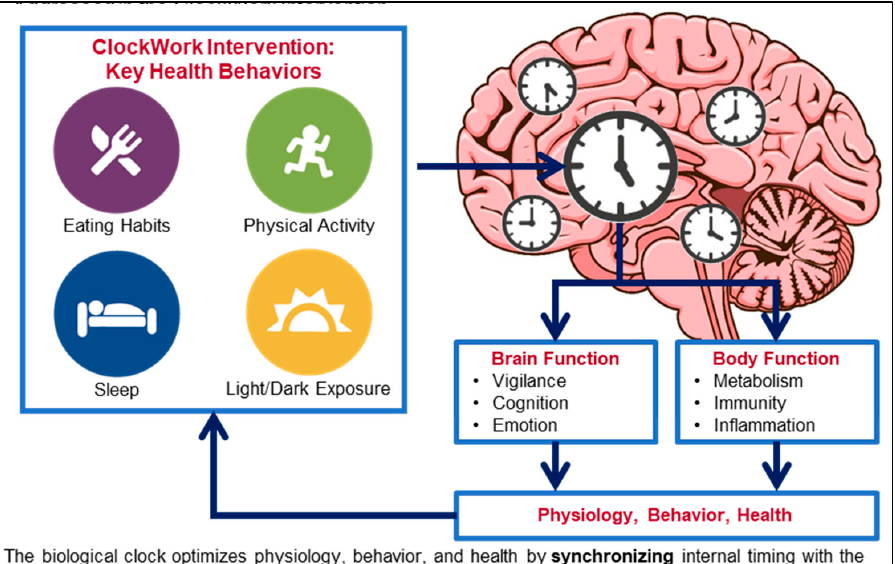
Figure 1. Conceptual model of the circadian timing system and key health behaviors addressed in the ClockWord intervention.